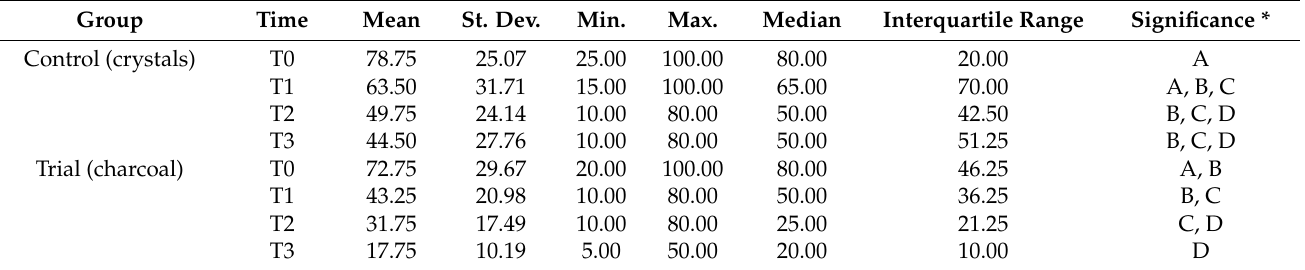
Table 4. Descriptive statistics of PCR, and significant intragroup and intergroup differences assessed